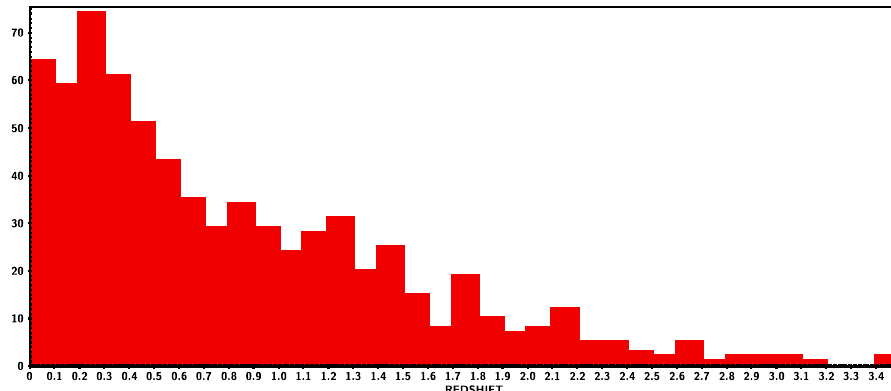
Figure 2. Redshift distribution of the checked sources.